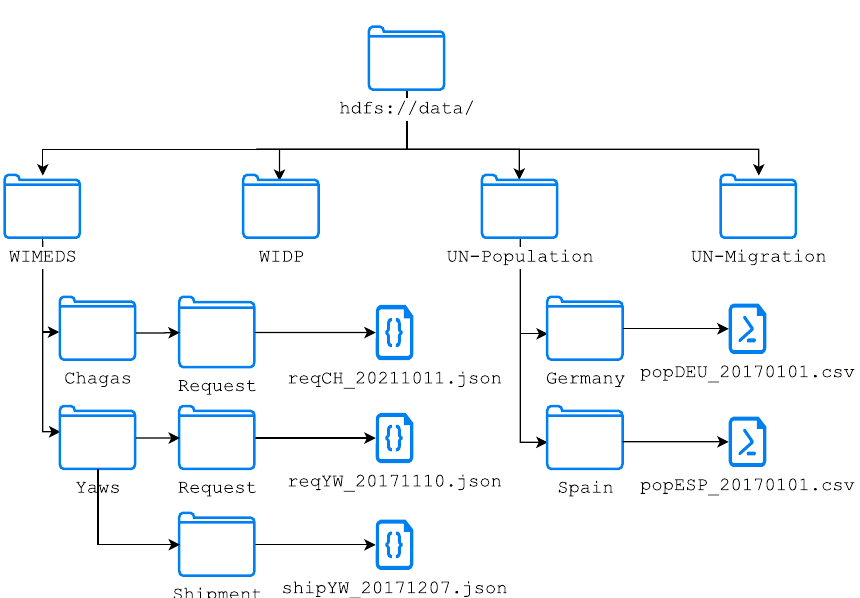
Fig. 4 Example of the Temporal Landing for the NTD-related